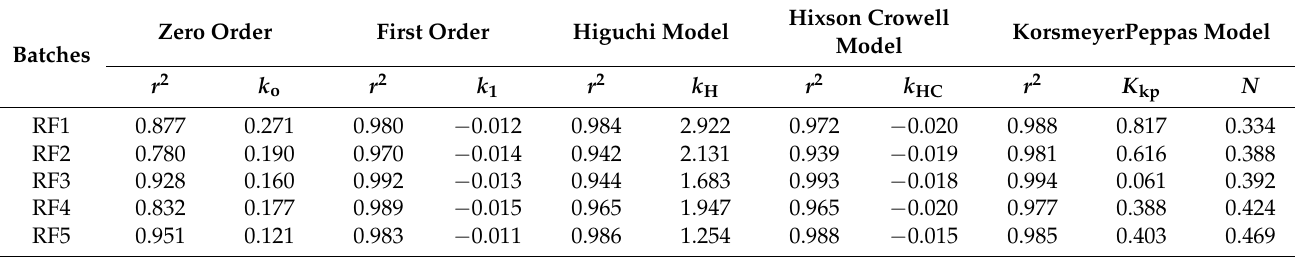
Figure 6. In vitro release of various formulation batches of microfibers. Table 3. Drug release kinetic modeling data of various microfiber batches.